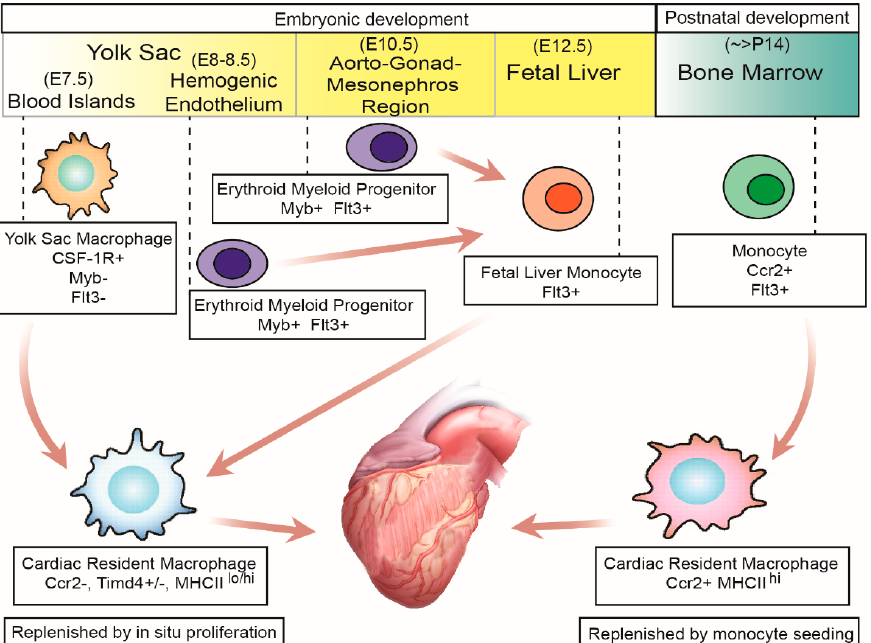
Figure 1. Derivation of cardiac-resident macrophages during embryonic and postnatal development. During embryonic development, cardiac-resident macrophages are derived from either yolk-sac macrophage-derived or fetal liver monocyte-derived cardiac-resident macrophages. The former develop, starting around embryonic day 7.0 (E7.0), and migrate to the heart at E7.5. The latter are derived from the erythroid myeloid progenitors from the hemogenic endothelium of the yolk sac (E8.0–8.5) and from the hemogenic endothelium of the aorto-gonad and mesonephros (AGM) region (E10.5). Fetal liver monocyte production starts at E12.5. Embryonic-derived cardiac-resident macrophages endure in the heart primarily by proliferation in situ. Bone marrow monocyte-derived cardiac-resident macrophages appear in the heart starting around postnatal day 14 (P14) and endure in the heart by continuous monocyte seeding from the circulation.